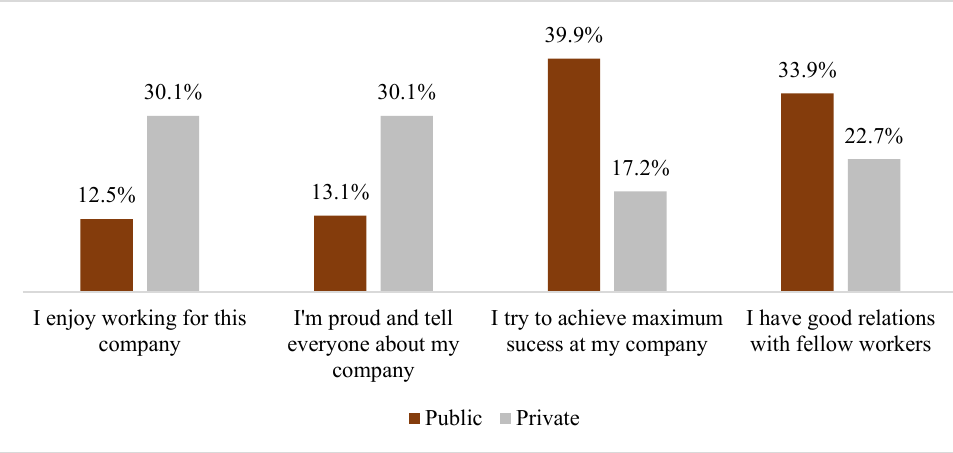
Fig. 3. Job satisfaction. Source: The authors’